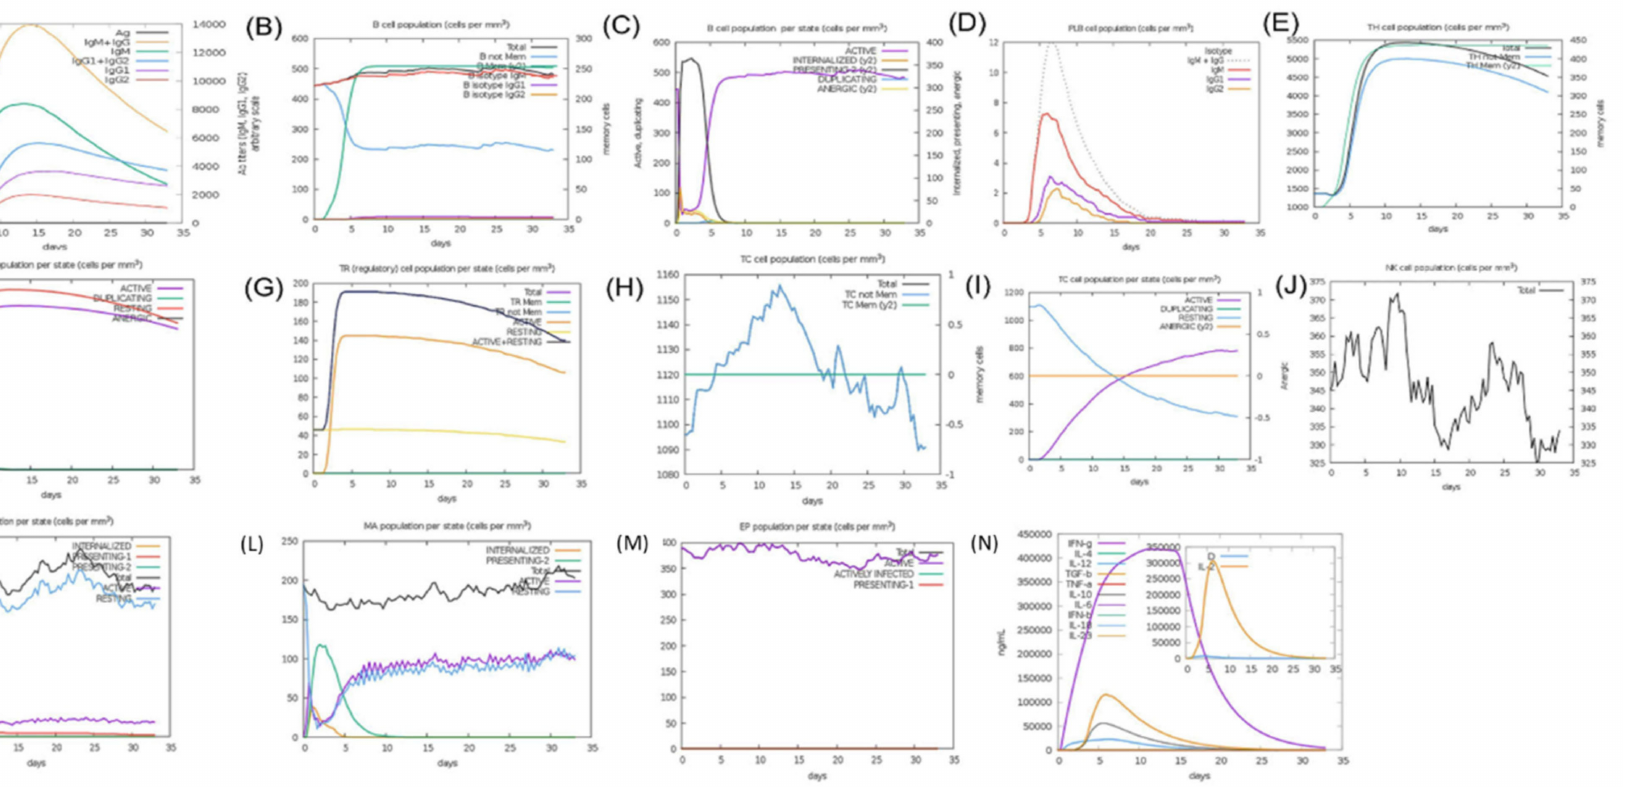
Figure 9. In silico immune simulations. The potential induction of immune response factors upon injection of the constructed immunogen as an antigen. ( A ) shows the total antigen and immunoglobulin counts, ( B ) shows the total (per mm 3 ) B-cell production, ( C ) shows the levels of B-cell lymphocyte production, ( D ) shows production of Plasma B lymphocytes, ( E ) shows the total (per mm 3 ) of CD4 T-helper lymphocytes produced, ( F ) shows the total CD4 T-helper lymphocytes produced, ( G ) represents the CD4 T-regulatory lymphocyte production, ( H ) represents the CD8 T-cytotoxic lymphocyte production, ( I ) represents the CD8 T-cytotoxic lymphocyte production, ( J ) represents natural killer cell production, ( K ) represents dendritic cell production, ( L ) represents macrophages produced, ( M ) represents epithelial cells produced, and ( N ) represents the production of immune specific IFN-g and IL-2 (Cytokines)